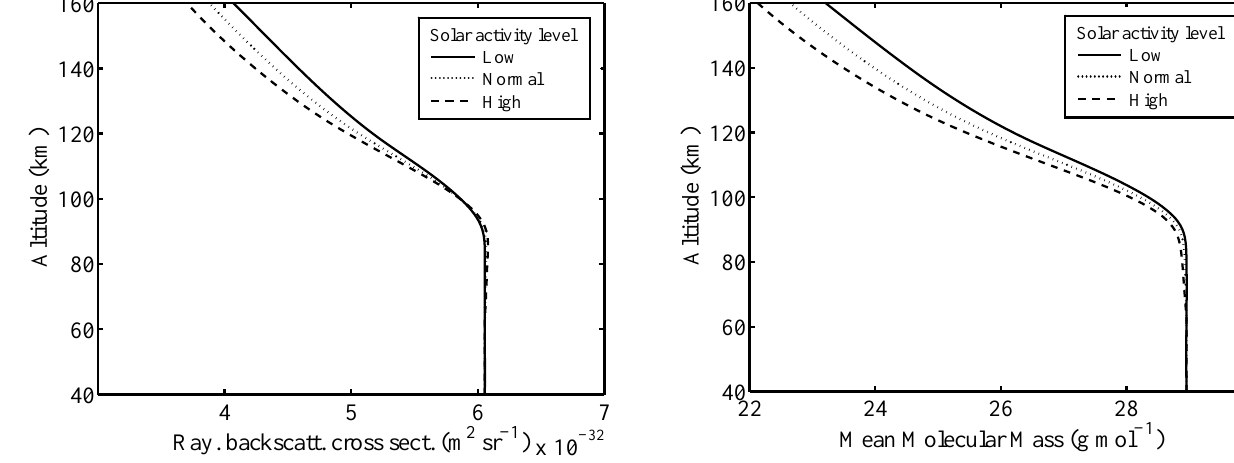
Fig. 2. Mean molecular mass a function of